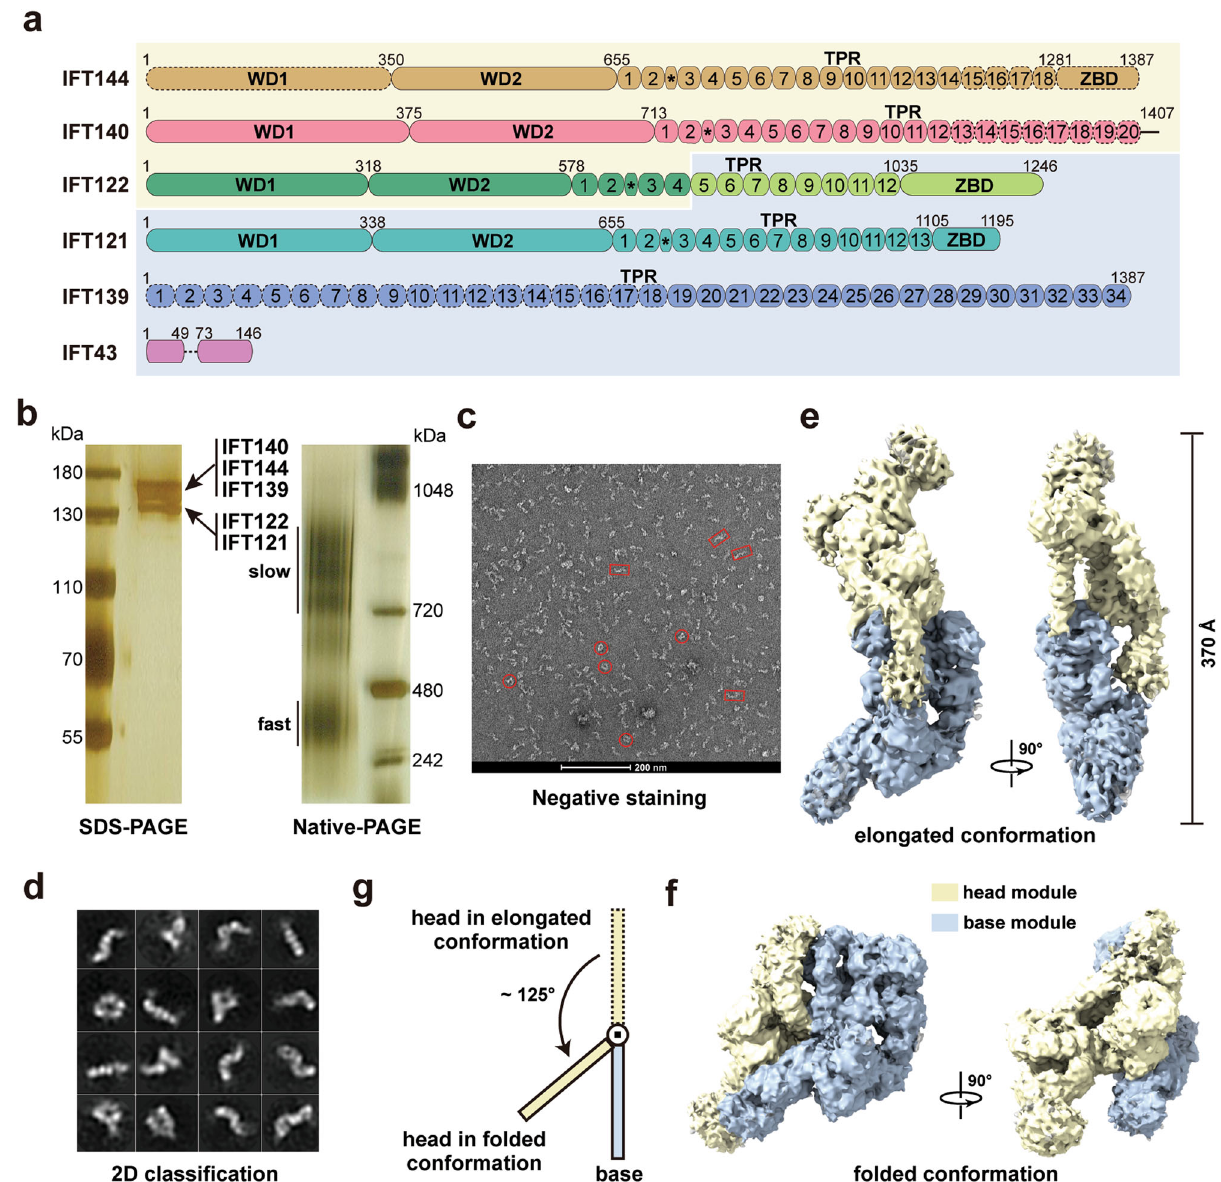
Fig. 1 | Overall structure of the IFT-A complex in two different conformations. a DomainorganizationsoftheIFT-Acomponents.IFT144,IFT140,IFT122 N ,IFT122 C , IFT121, IFT139 and IFT43 are colored goldenrod, salmon, green, green yellow, tur- quoise, blue and violet, respectively. Black asterisks indicate the helices inserted between the second and third TPR repeats in IFT144, IFT140, IFT122, and IFT121. The head and base module components have light yellow and pale blue back- ground colors, respectively. Models of IFT144 WD1 , IFT144 C , IFT140 C and IFT139 N built with the aid of AlphaFold-2 are shown in dashed ovals or circles. The middle disordered loop of IFT43 is shown in a dashed line. b Silver staining SDS-PAGE gel (left) and native-PAGE gel (right) showing the purity and major conformations of